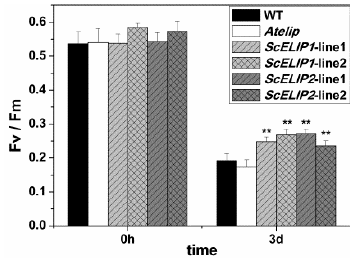
Figure 7. Photosynthetic parameters for WT, Atelip, and 35S-ScELIP1 or 35S-ScELIP2 at 0 h (prior to treatment) and 3 days of high-light exposure (1000 μ mol/m 2 /s). Error bars represent the SD of three biological repeats. ** p < 0.01, P-values were obtained from Dunnett’s T3 test comparing WT and the transgenic lines with the Atelip mutant, respectively. Fv / Fm: Maximal quantum yield of PSII, Y(II): Actual quantum yield of PSII, ETR: Photosynthetic electron transport rate.